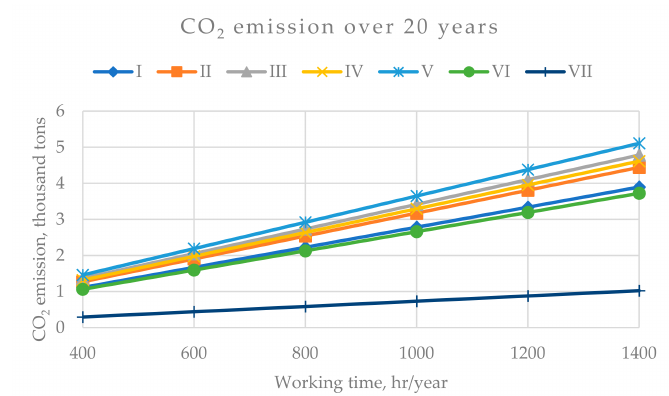
Figure 4. CO 2 emissions of individual heating systems for an operating time of 400 to 1400 h over a